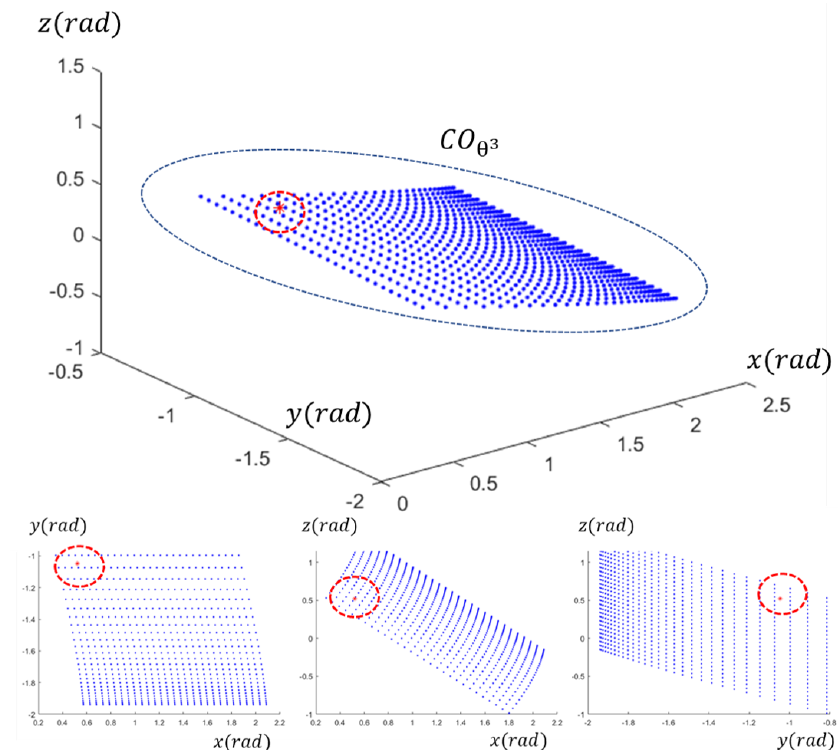
Figure 11. The resulting graph of the generated obstacle image. The three bottom images are views of 2-dimensional space: x-y, x-z, and y-z.